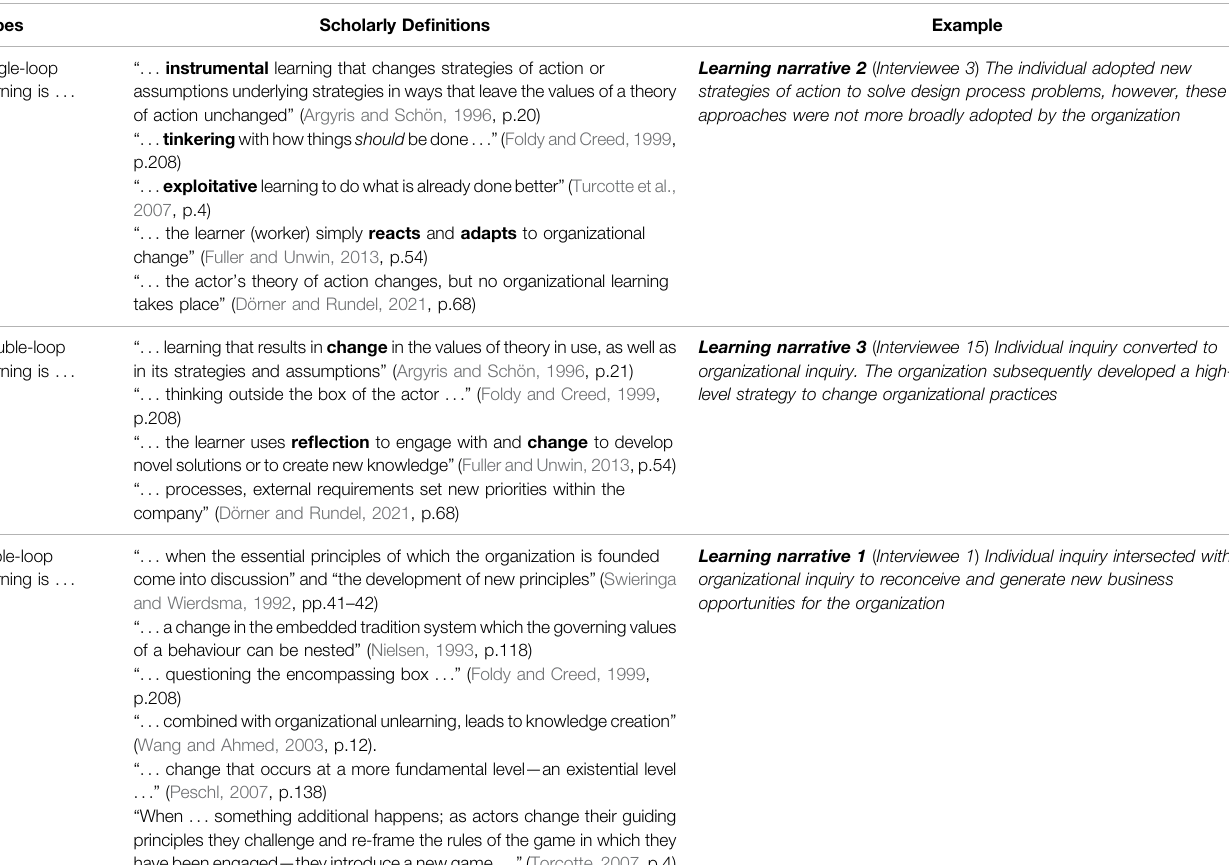
TABLE 1 | Organizational learning